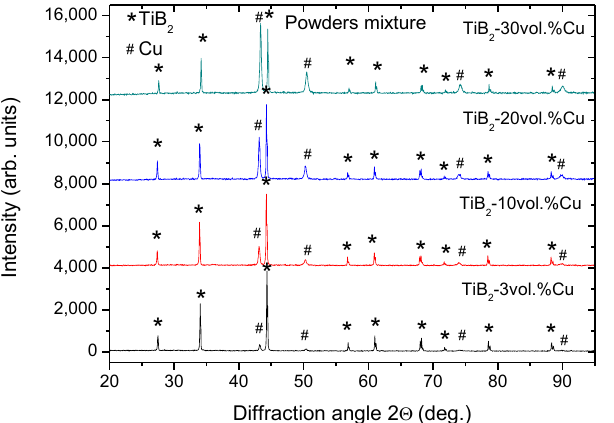
Figure 10. The XRD pattern for powders mixture for powders with the Cu content from 3 to 30 vol.